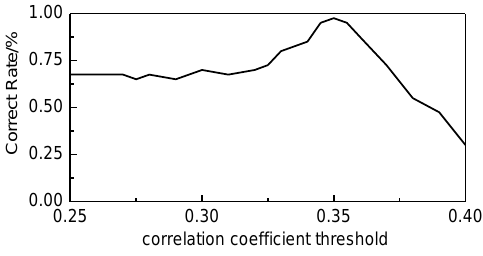
Figure 7. The accuracy of decomposition.